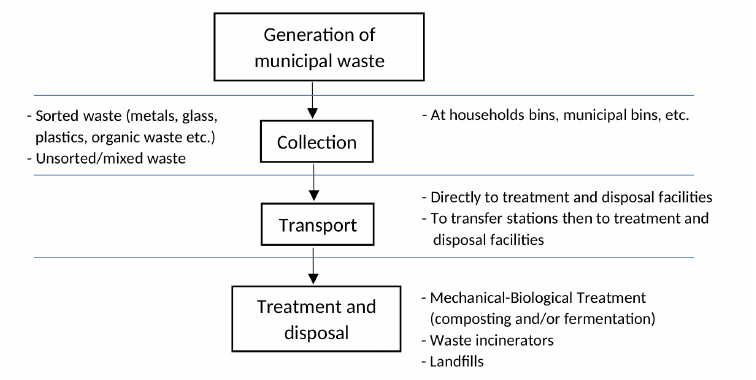
Figure 1. Simplified scheme of waste management system, based on